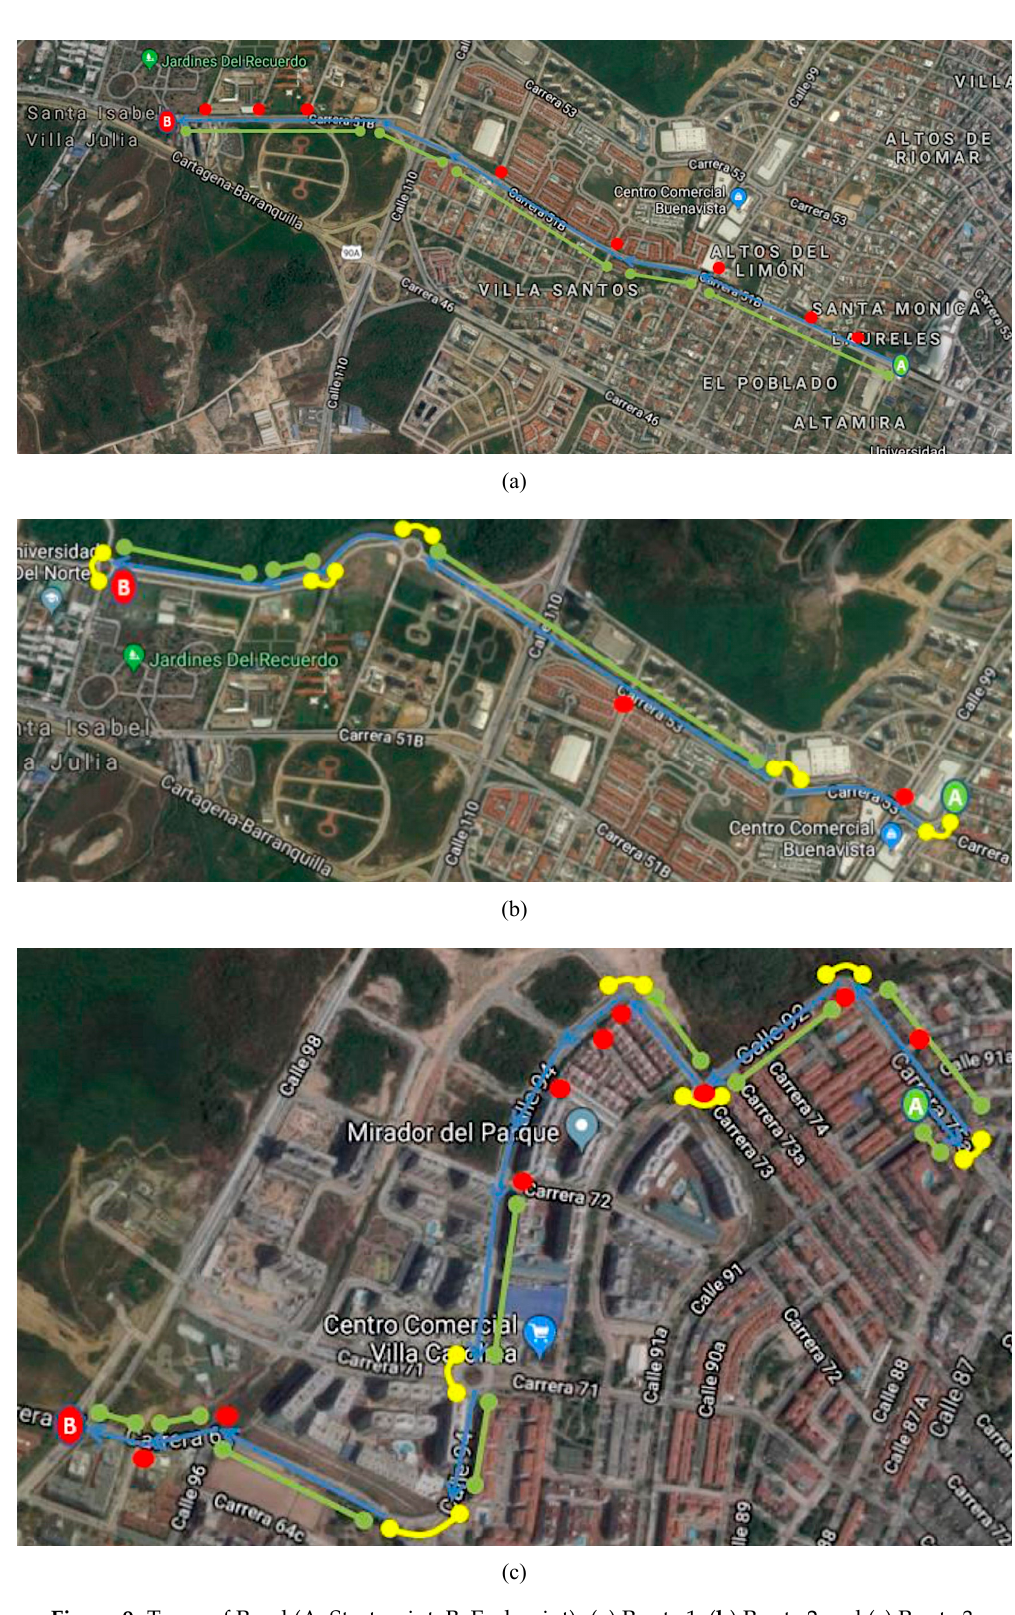
Figure 9. Types of Road (A: Start point, B: End point): ( a ) Route 1, ( b ) Route 2 and ( c ) Route 3.